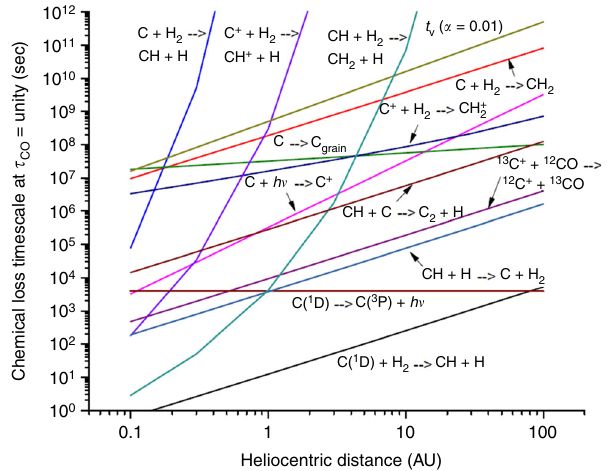
Fig. 7 Chemical loss timescales for several carbon species computed at the FUV surface of the nebula and as a function of heliocentric distance. The fi gure shows that excited state carbon, C( 1 D), is lost to reaction with H faster than for any other loss pathway. The C ionization reaction to form C + is FUV radiation from the protosun; nearby O stars can also be a signi fi cant source of FUV radiation. The timescale for the reaction CH + H → C + H 2 was computed assuming an H/H 2 fraction = 0.01. This reaction returns C atoms to the gas in their ground state, allowing ionization and exchange to remove the C isotope self-shielding signature. Depending on the degree of dust settling and the CO fraction, the H/H 2 ratio can be higher or lower by a factor of ~10 2 − 10 3 (ref. 66 ). A much lower H/H 2 ratio allows the reaction CH + C → C 2 + H to sequester the self-shielding signature in C 2 . Reaction of CH with H 2 also becomes much faster inside of 1 AU, providing